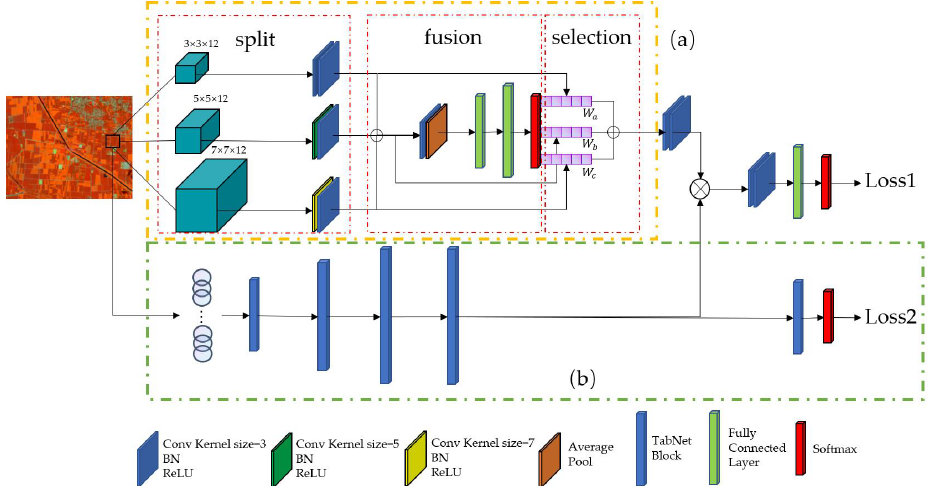
Figure 7. The proposed SPTNet’s framework for crop mapping using a novel DNN architecture. ( a ) The selective patch module. ( b ) The branch of central pixel spectral feature